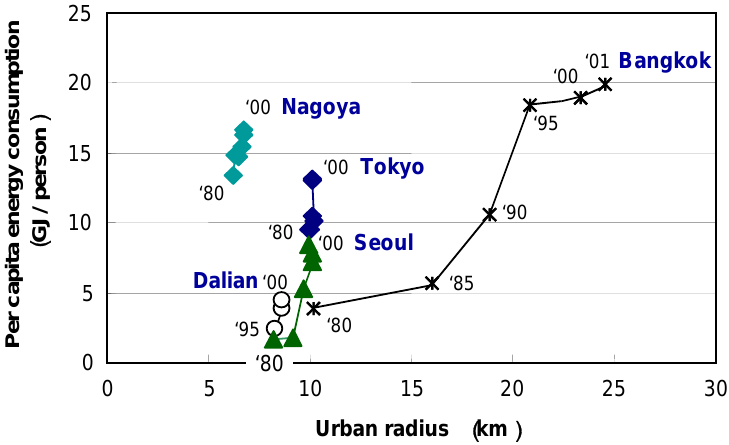
Figure4. Urban expansion and its effect on transport energy